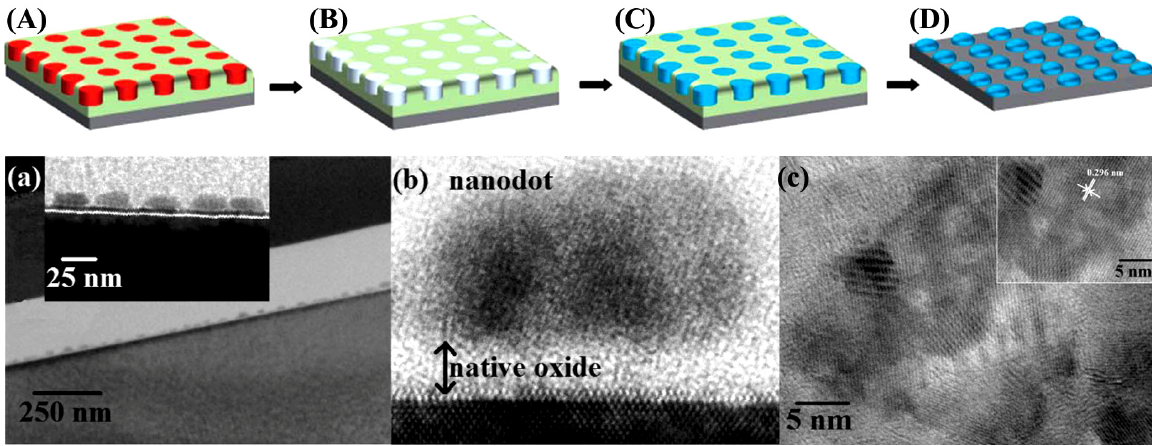
Figure 26. Schematic illustration of the fabrication of oxide nanodots: ( A ) highly ordered PS- b -PEO thin film prepared by a solvent annealing process; ( B ) nanoporous template produced by activation of the PEO cylinders upon exposure to ethanol at 40 °C for 15 h; ( C ) the metal oxide precursor diffuses into the cylinders after spin coating the metal nitrate solution; and ( D ) oxide dots remaining after the ultraviolet (UV)/ozone treatment. ( a ) TEM cross-sectional image of iron oxide nanodots; the inset shows a higher magnification image; ( b ) cross-sectional HRTEM image for a single nanodot; and ( c ) HRTEM image for the nanodots after the UV/ozone treatment; the inset shows crystalline fringes O . Reprinted with permission from [49]. Copyright 2012 Royal corresponding to Fe 3 4 Society of